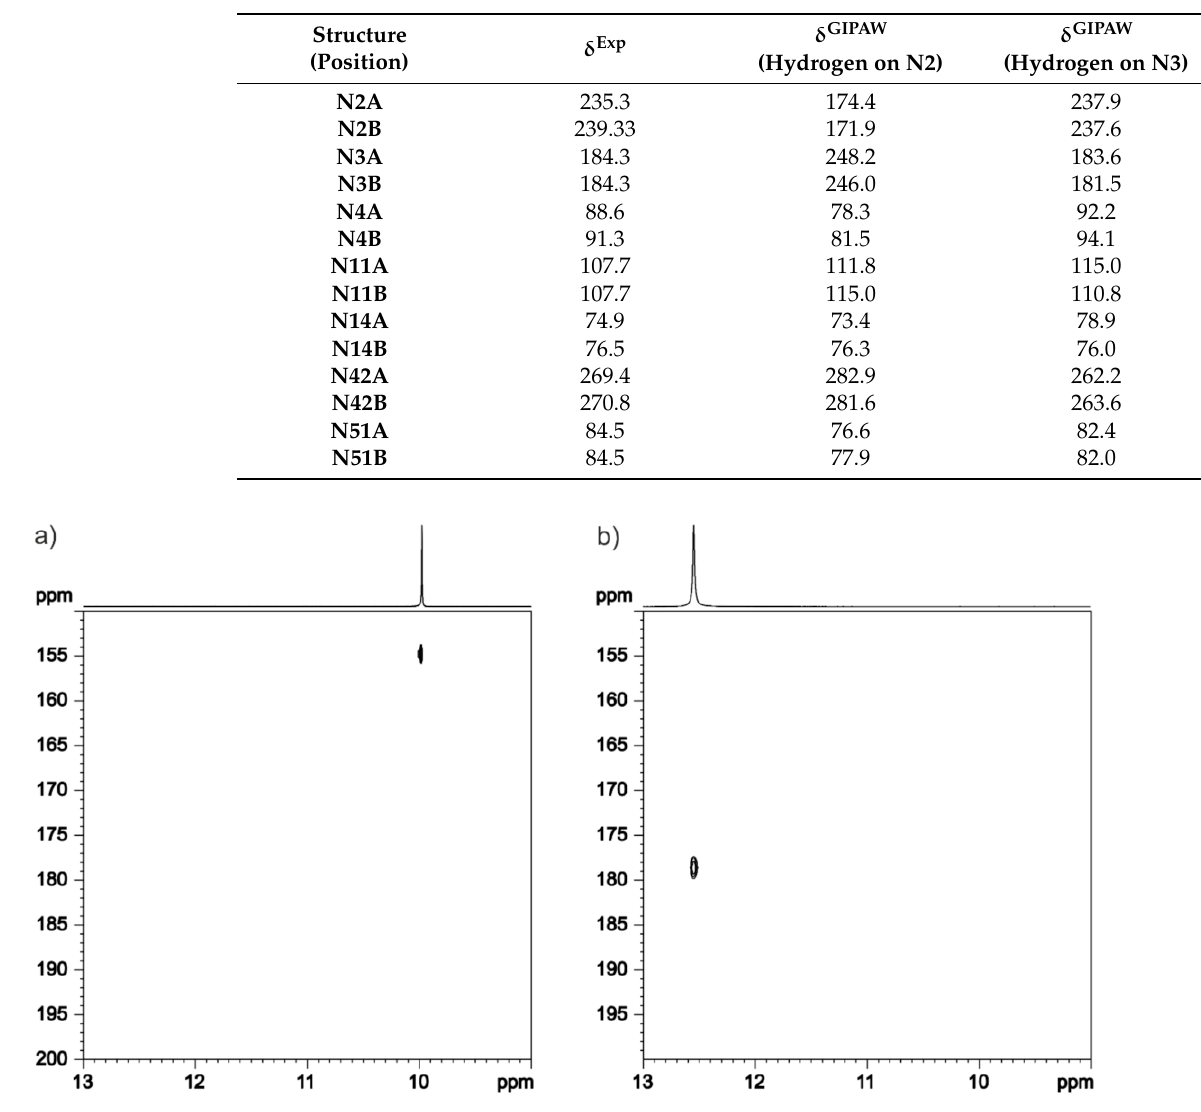
Table 10. 15 N CP MAS NMR experimental and GIPAW calculated chemical shifts ( δ ) [in ppm] (recalculated from GIPAW nuclear shieldings from equation δ = 230 − σ GIPAW ) for compound 4 with the hydrogen attached to the nitrogen in position N2 or N3 in the crystal structure.